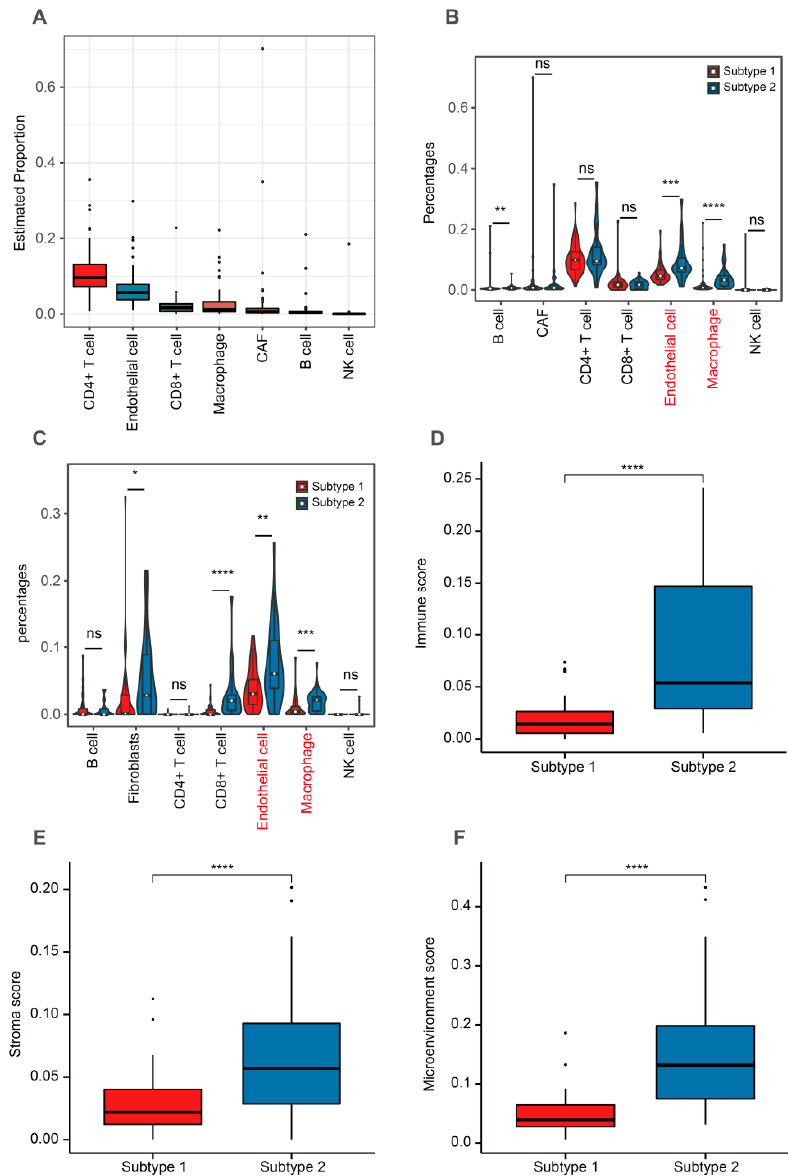
Figure 7. Comparison of tumor infiltrating features between two TME-related subtypes. ( A ) The estimated proportions of seven cells according to the EPIC algorithm. ( B ) Comparison of the proportions of these seven cells calculated through the EPIC algorithm between two subtypes. ( C ) Comparison of the proportions of these seven cells calculated through the xCell algorithm between two subtypes. ( D – F ) Comparison of TME-related scores between subtypes 1 and 2. Data in ( B – F ) were analyzed by Wilcoxon test; ns: No significance, * p < 0.05, ** p < 0.01, *** p < 0.001 and **** p < 0.0001.